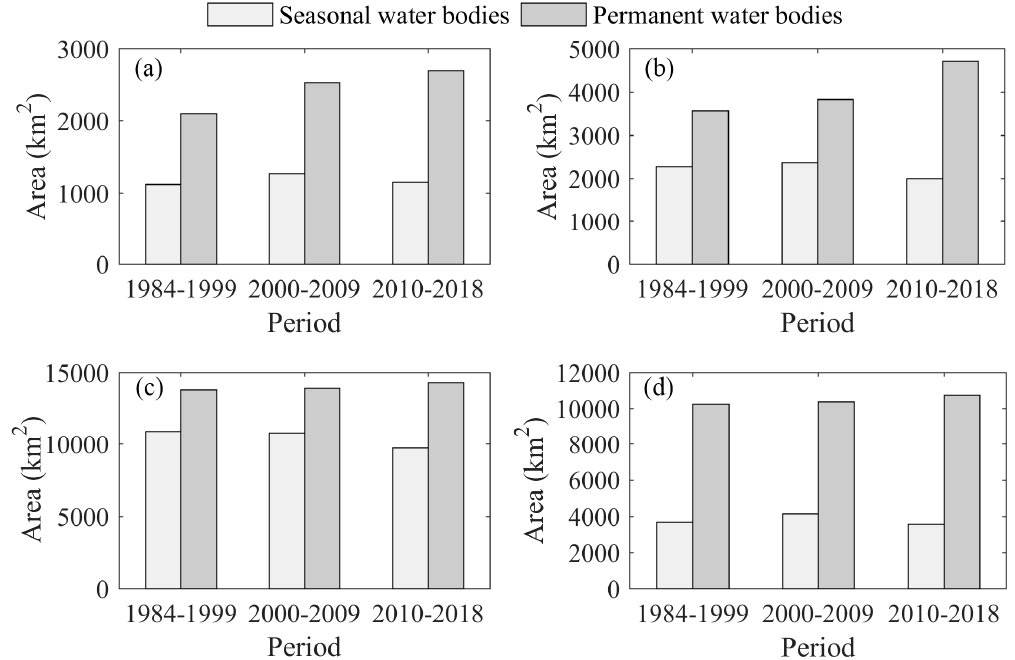
Figure 8. The area of open-surface water bodies during different periods in the ( a ) source of the YRB (SYRB), ( b ) the upper reaches of the YRB (UYRB), ( c ) the middle reaches of the YRB (MYRB), ( d ) and the lower reaches of the YRB (LYRB).